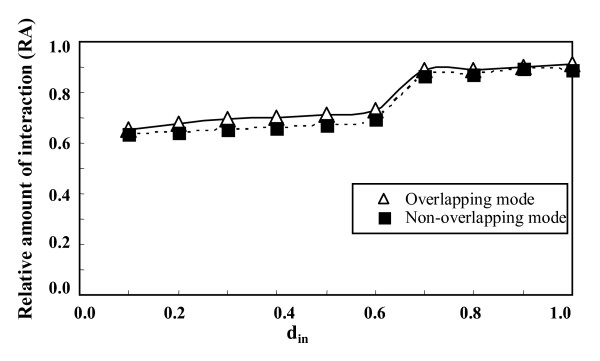
Relative amount of interactions involving similar function protein pairs in 20 sets of yeast complexes against corresponding din values.